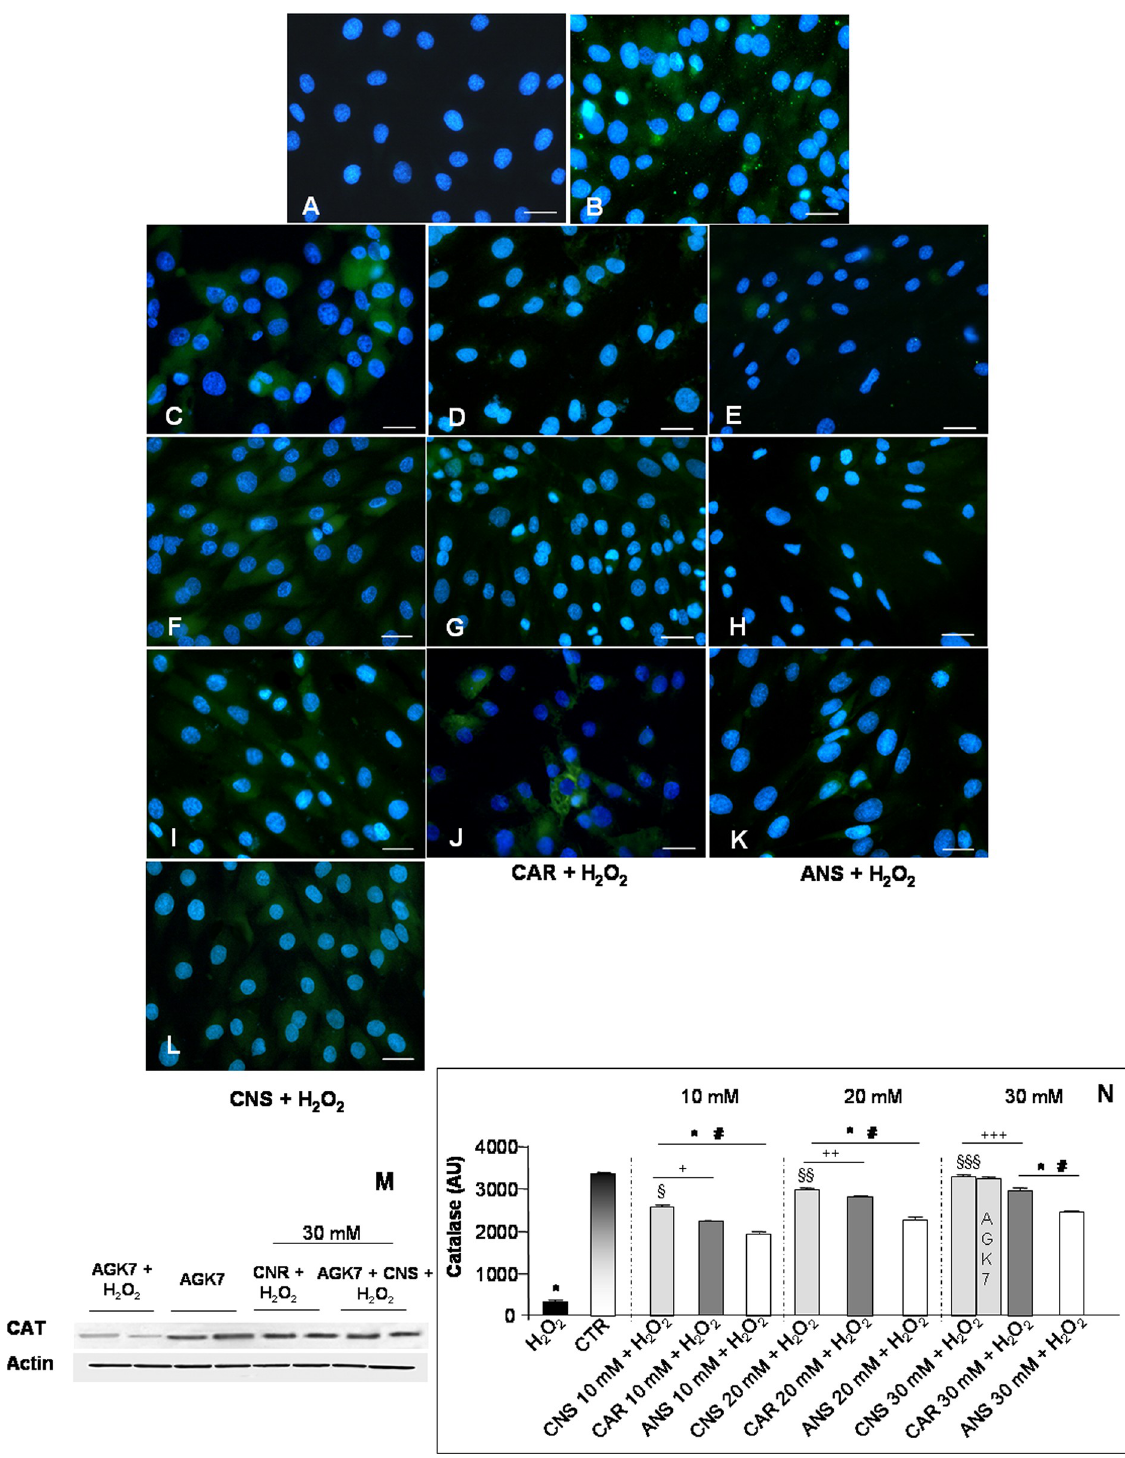
Fig 6. Catalase expression. Immunofluorescence photomicrographs of catalase (CAT—green staining) of myotubes treated with hydrogen peroxide—H 2 O 2 (A), untreated control myotubes—CTR (B), myotubes pre-incubated with carnosinol followed by H 2 O 2 -treatment—CNS + H 2 O 2 (C, F, I), pre-incubated with carnosine followed by H 2 O 2 -treatment—CAR + H 2 O 2 (D, G, J) and pre-incubated with anserine followed by H 2 O 2 -treatment—ANS + H 2 O 2 (E, H, K) at the concentrations of 10 mM (C-E), 20 mM (F-H) and 30 mM (I-K) and myotubes incubated with AGK7 then with carnosinol (30 mM) and followed by H 2 O 2 -treatment—AGK7 + CNS + H 2 O 2 (L). Bar equal: 20 μ m. (M) Representative western blot showing CAT level in myotubes incubated with AGK7 and then with hydrogen peroxide—AGK7 + H 2 O 2 , myotubes incubated only with AGK7—AGK7, myotube pre-incubated with carnosinol (30 mM) followed by H 2 O 2 -treatment—CNS + H 2 O 2 and myotubes incubated with AGK7 then with carnosinol (30 mM) and followed by H 2 O 2 -treatment—AGK7 + CNS + H 2 O 2 . (N) The